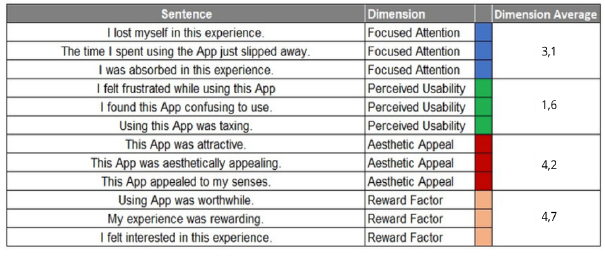
Figure 9. UES Results ­ Interaction at Carnaboi